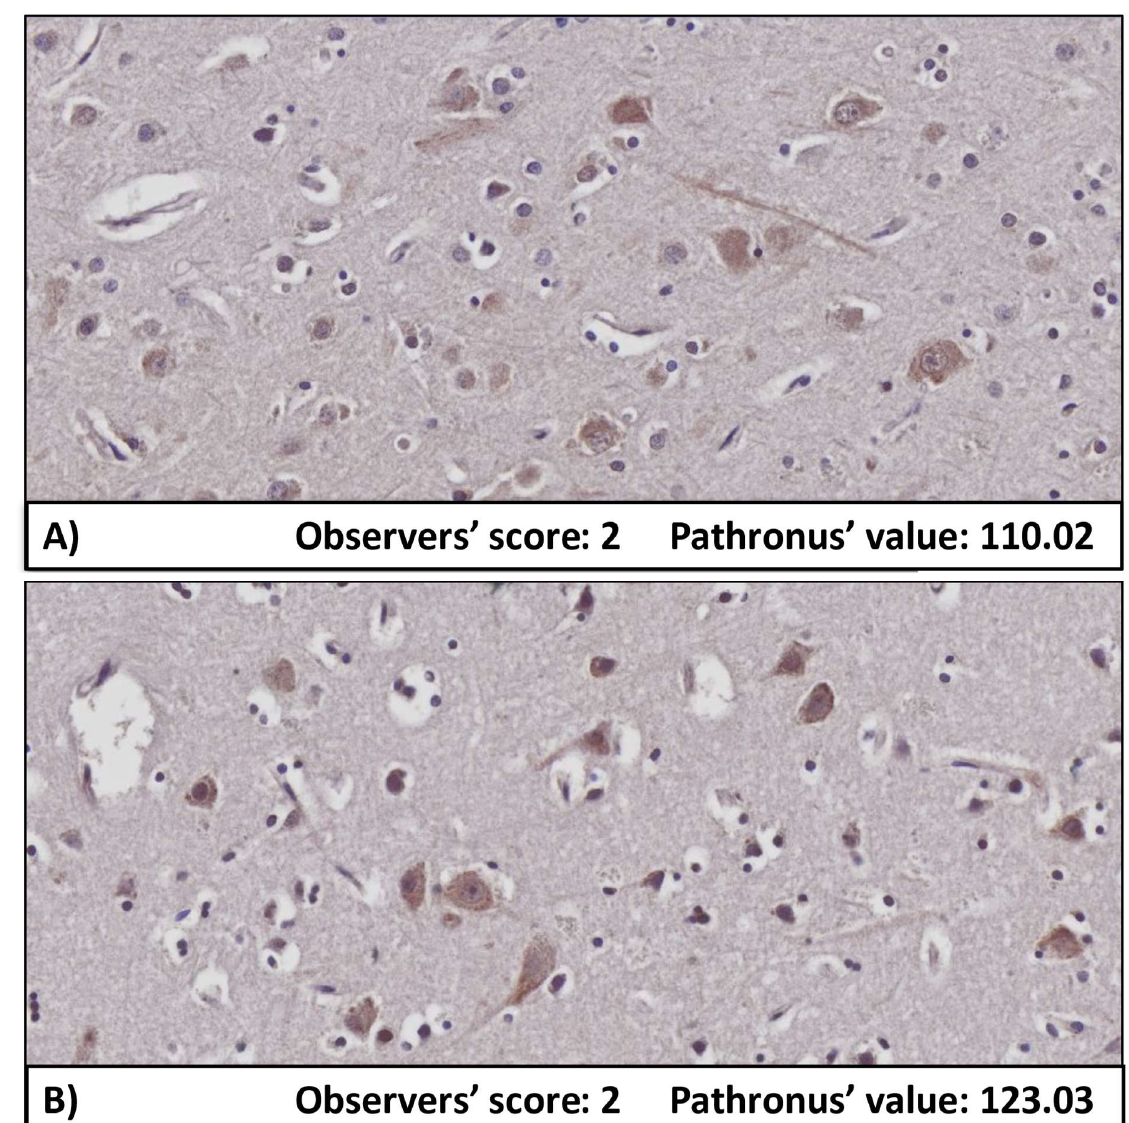
Figure 4. A remarkable limitation of semi-quantitative scoring compared to digital image analysis is the significantly smaller evaluation range (7 vs. 256) due to the difficulties that are experienced when attempting to detect subtle differences in the labelling intensities using the human eye alone. The observers allocated a score of 2 to both of the images, whereas the Pathronus original method revealed that the intensity of Panel A was 110.02, while that of Panel B was 123.03 on the grayscale (ranged between 0–255). Although the human eye is capable of perceiving small differences, the objective and reproducible categorization of hundreds of images on an extended scale is not possible for human observers whereas possible for a digital image analysis software. This shortage of semi-quantitative scoring may result in statistical bias compared to software-based